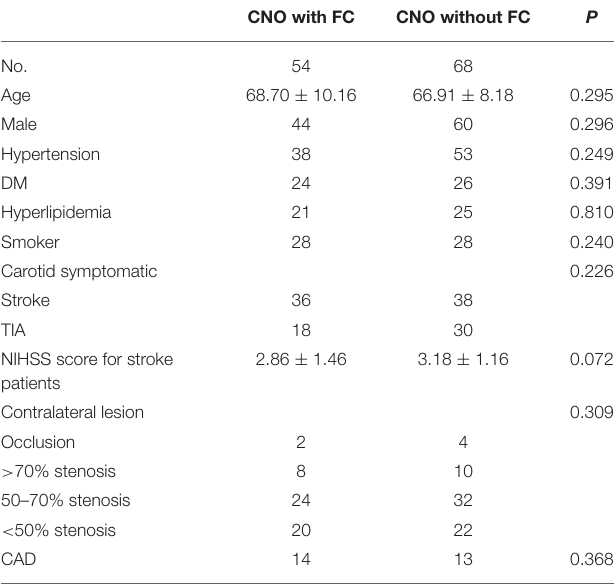
TABLE 1 | Demographics and clinical features of the study